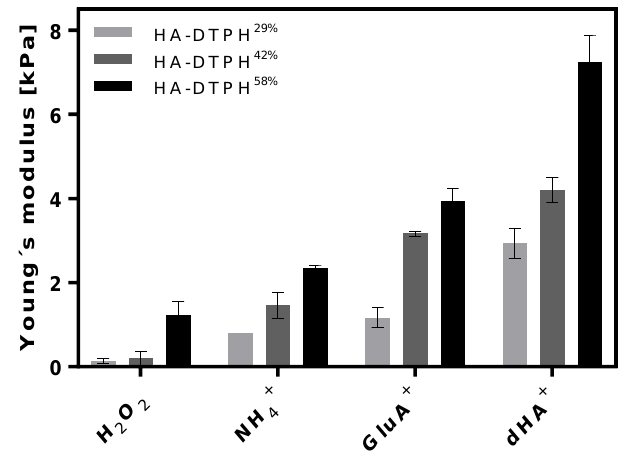
Figure 3. Young’s modulus of hydrogels with three thiolation degrees of HA-DTPH-Ox. and HA-DTPH-Cl + hydrogels.